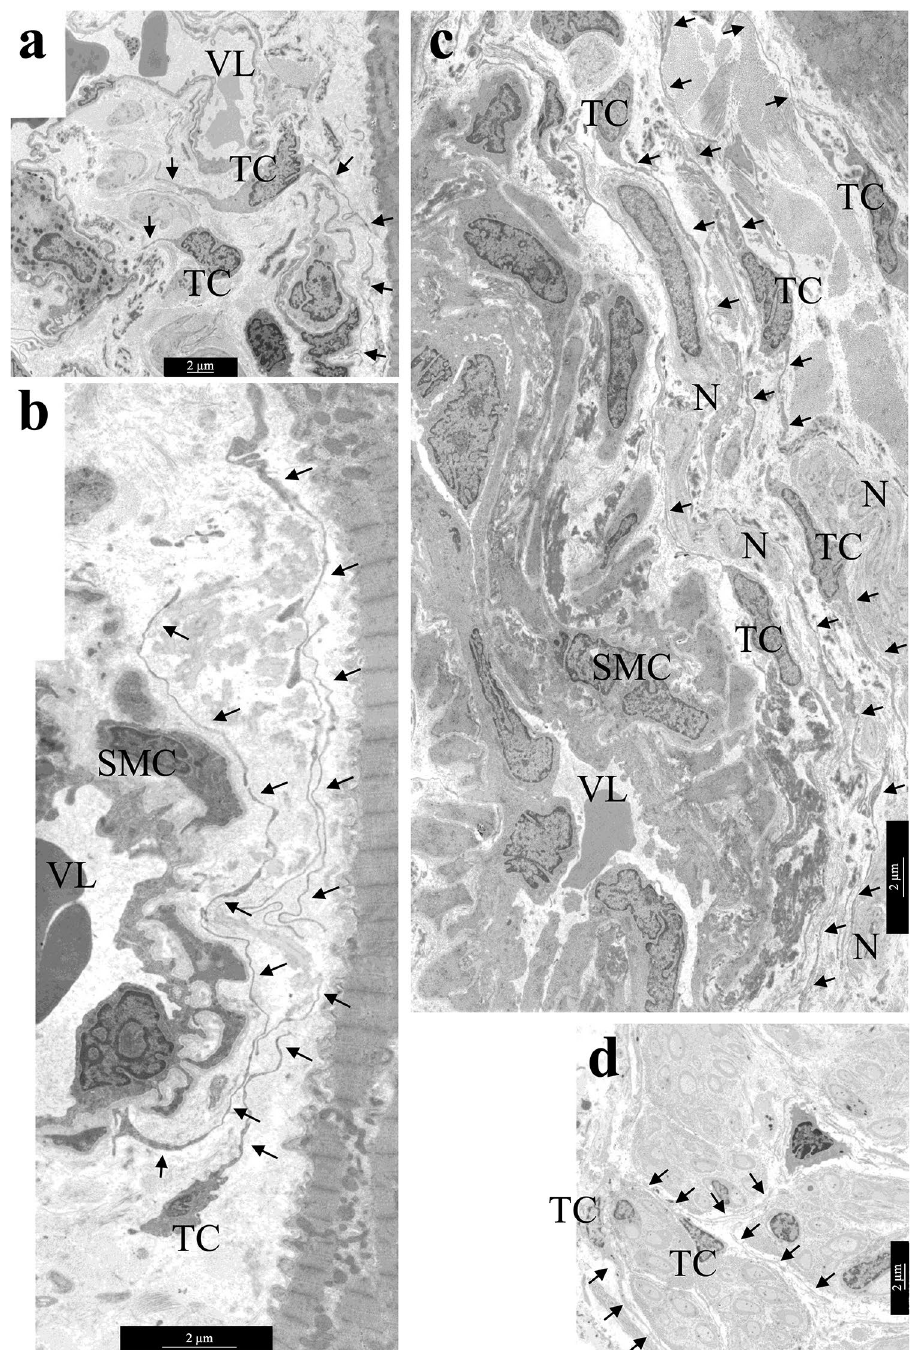
Figure 3. The location of TCs in the interstitial area—around large and small vessels, next to cardiomyocytes and nerve fibers. ( a ) TCs next to capillary. ( b ) TC near arteriole. ( c ) TCs in perivascular space — next to a relatively large vessel. ( d ) TCs inside the nerve fiber. TCs processes are indicated by arrows. TC—telocyte. N — nerve fibers. SMC—smooth muscle cells. VL—vessel lumen. bar 2